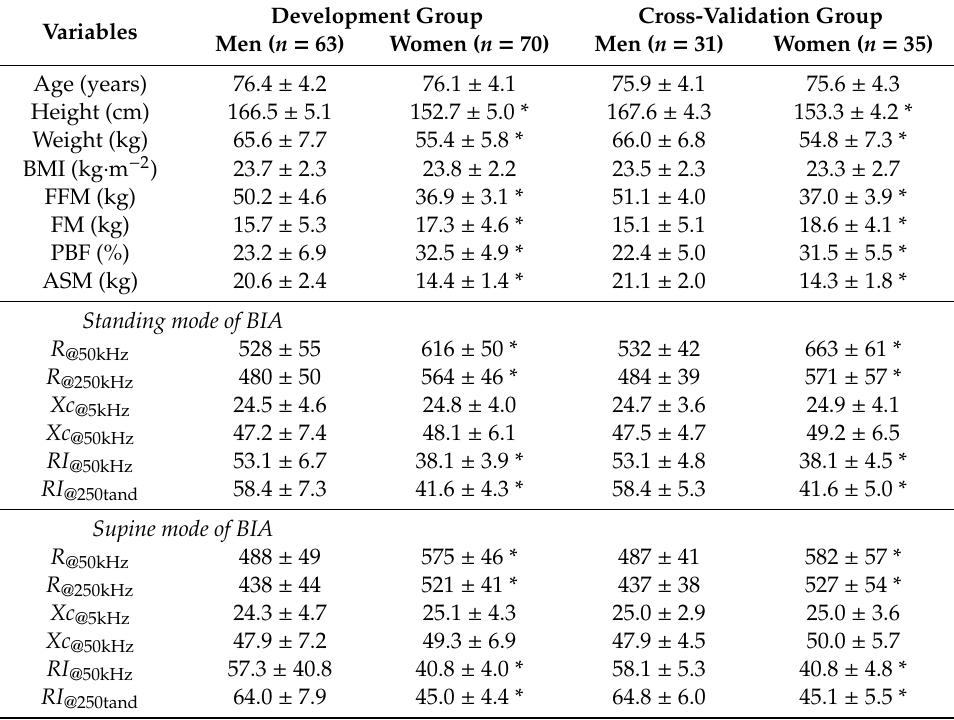
Table 1. General characteristics of the participants for development and validation of